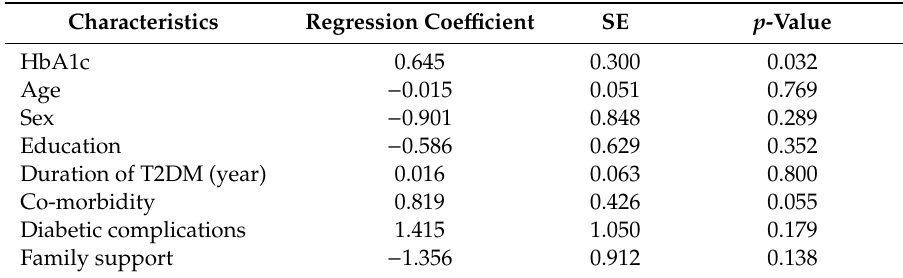
Table 5. Association between Hemoglobin A1c (HbA1c) and diabetes-related distress, using multiple linear regression